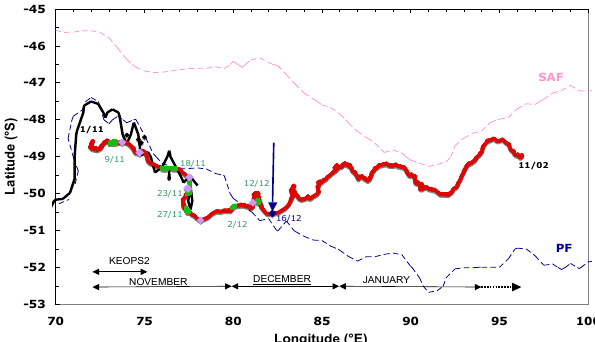
Figure 1. Trajectory followed by the CARIOCA drifter from 1 November 2011 to 12 February 2012 (red line). The green dots and numbers indicate the location and date where the data indicate a large signature of biological effects. The grey diamonds indicate high isolated salinity anomalies. The buoy enters the polar frontal zone at the location of the blue arrow. The pink dotted line rep- resents the location of the subantarctic front, the blue dashed line shows the location of the polar front (Park and Vivier, 2009, 2011) and the black line, the location of the polar front based on KEOPS2 observations, PF_Park (Park et al., 2014). The black dots indicate the location of the KEOPS2 stations (TEW-7, TEW-8, NPF-L) close to the